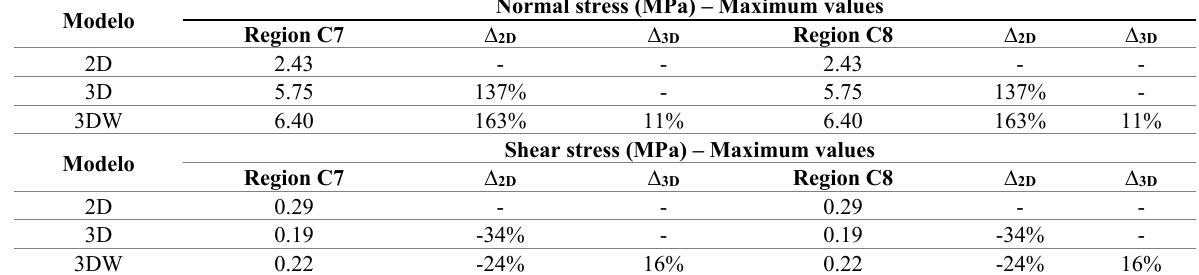
Table 7. Normal and shear stress at the bottom of Wall